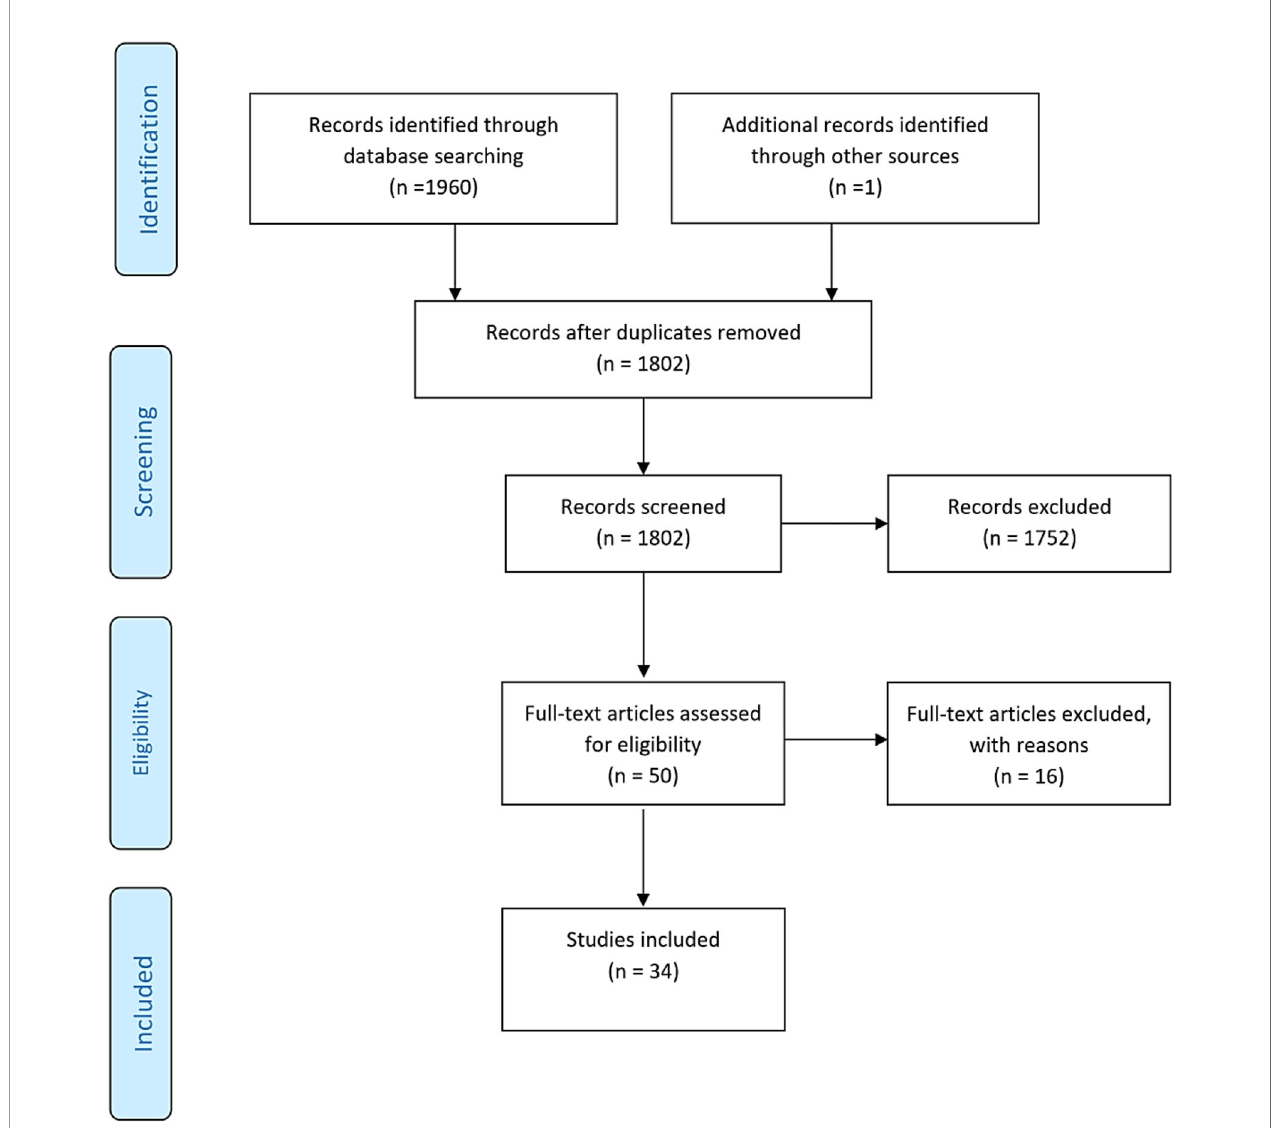
FIGURE 1 | PRISMA fl owchart outlining the process for selecting the included